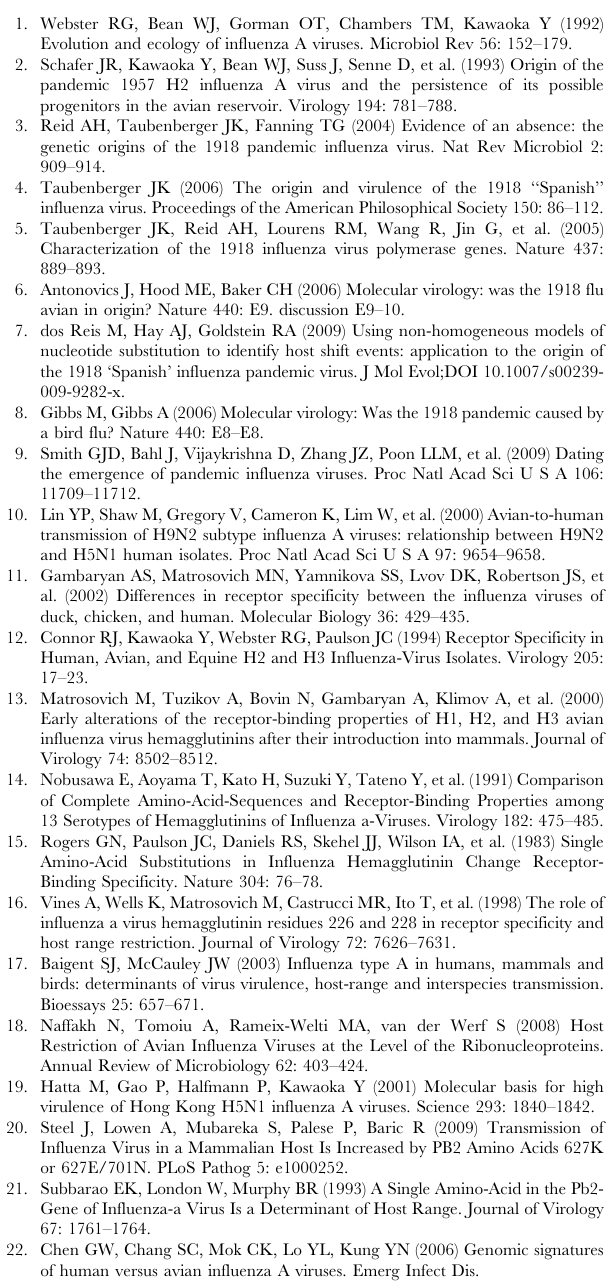
Figure S8 Phylogenetic tree of NP genomic segment. Avian section of the tree is in black, human in red. Figure S9 Phylogenetic tree of PA genomic segment. Avian section of the tree is in black, human in red. Figure S10 Phylogenetic tree of PB1 genomic segment. Avian section of the tree is in black, human in red. Figure S11 Phylogenetic tree of PB2 genomic segment. Avian section of the tree is in black, human in